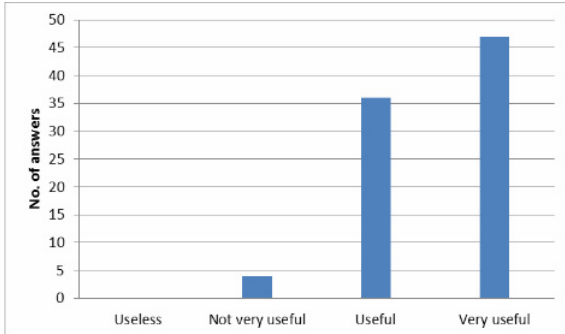
Figure 6. Results of Question